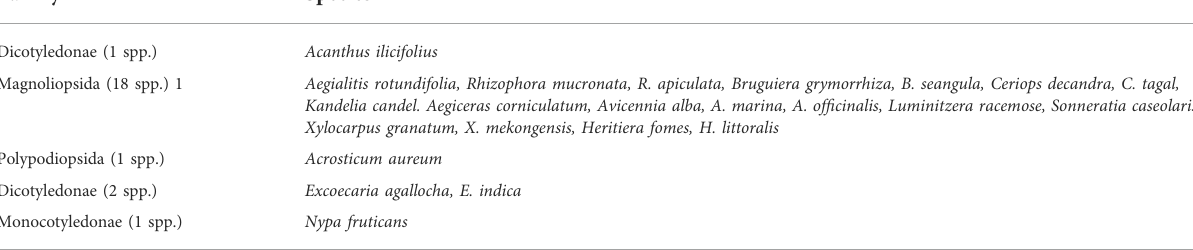
TABLE 5 Diversity of mangroves (23 spp.) in the estuarine waters of Bangladesh. Family Dicotyledonae (1 spp.)